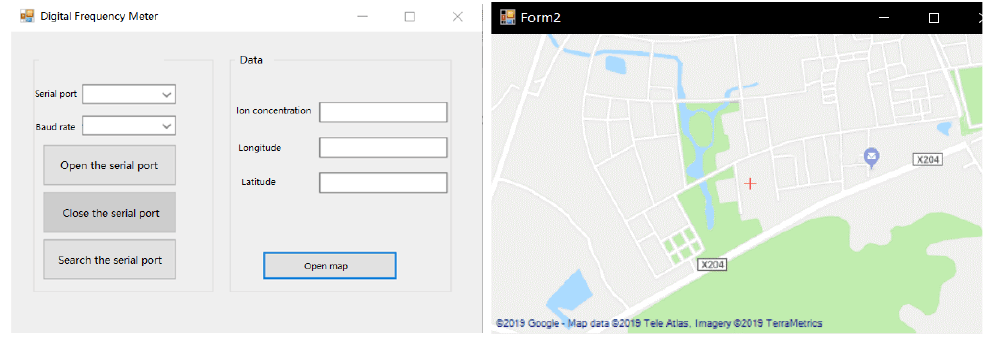
Figure 12. Upper computer